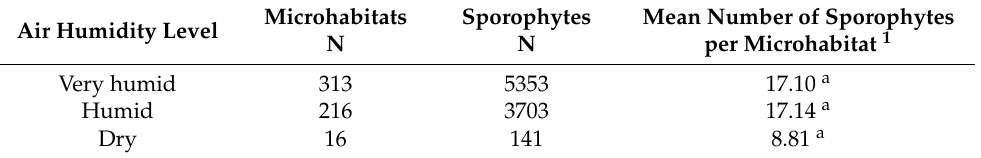
Table 7. Occurrences of Buxbaumia viridis depending on air humidity at the